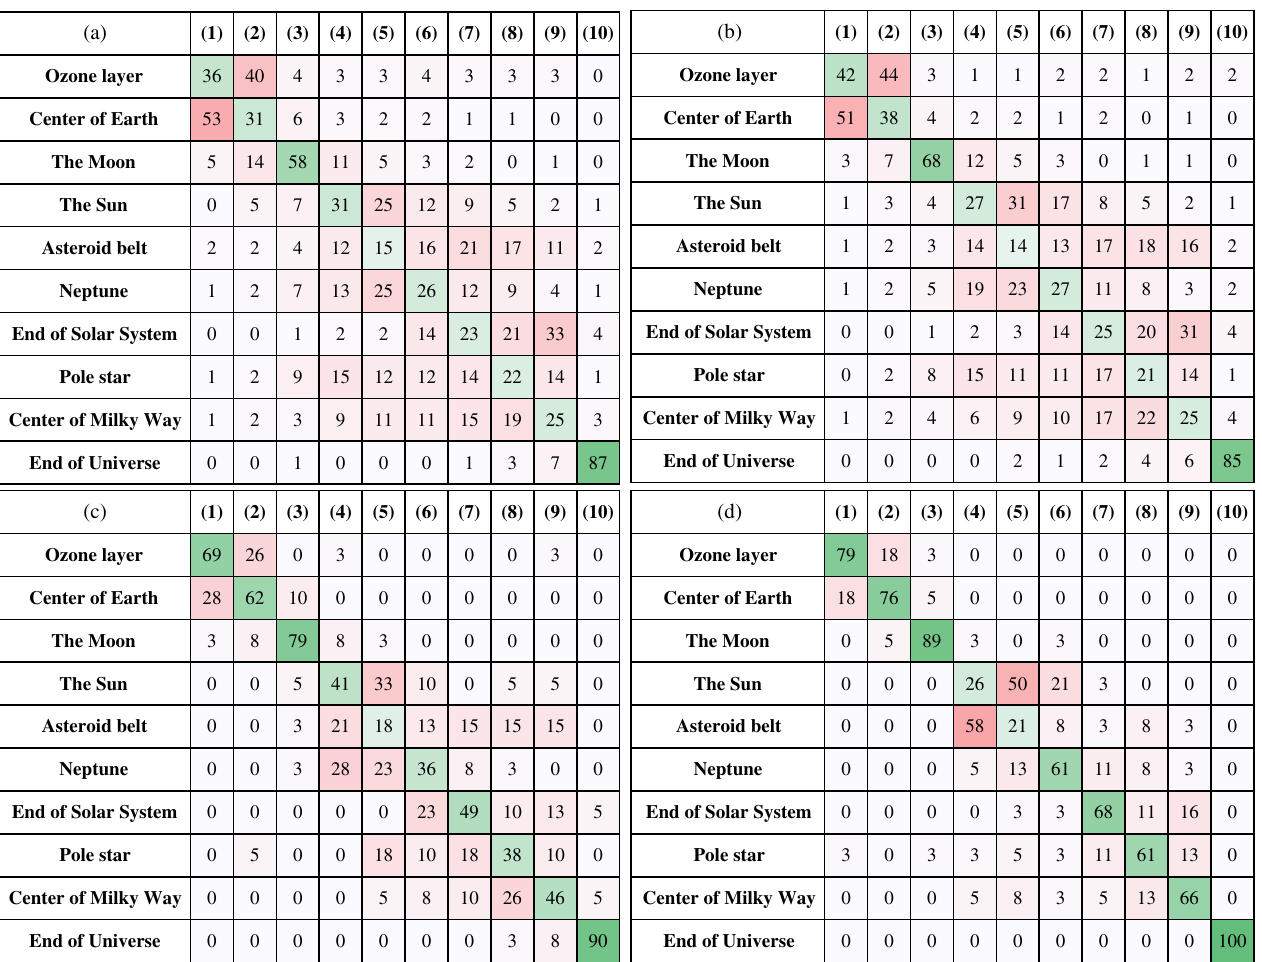
FIG. 5. Distance ranks assigned in Q7 to astronomical objects by middle school students (a) preinstruction and (b) postinstruction and preservice teachers (c) preinstruction and (d) postinstruction. The matrices here should be interpreted in the same way as those in Fig. 2. For example, matrix (a) tells us that only 36% of the preinstruction middle school students knew that the ozone layer is closest item to Earth ’ s surface, while a third of them wrongly thought that the end of the Solar System was the second-most distant item from Earth ’ s surface. The numbers of valid responses analyzed to produce each matrix, out of the total number of nonblank responses, were: (a) 440 out of 512, i.e., 86% (b) 313 out of 376, i.e., 83% (c) 39 out of 39, i.e., 100%, and (d) 38 out of 38,